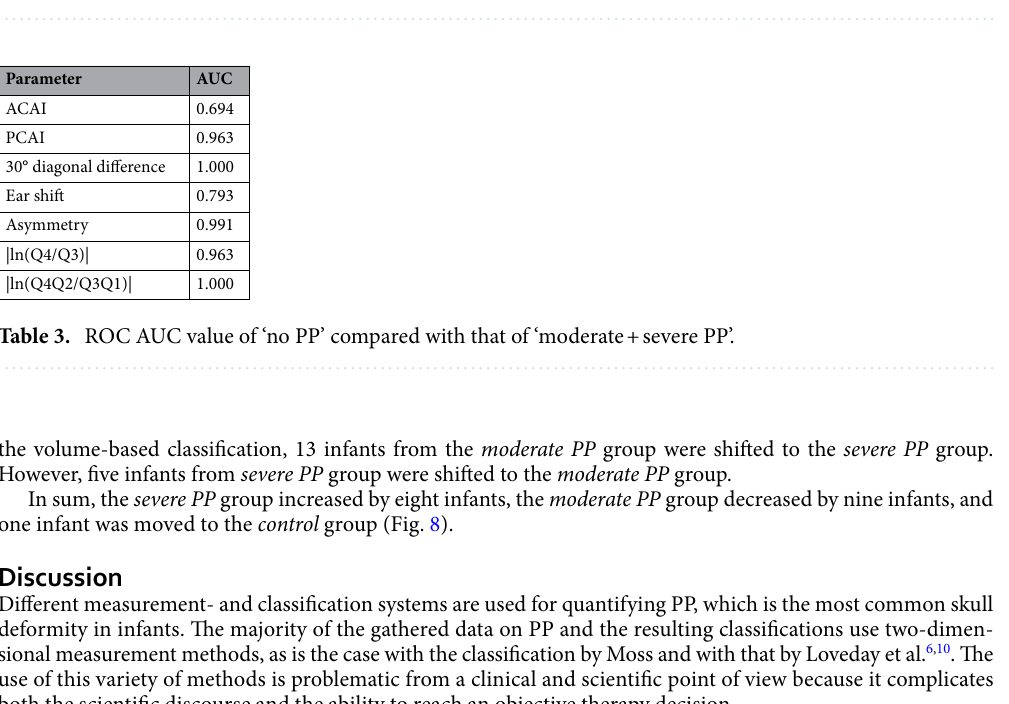
Figure 6. ROC curves of ‘no PP’ compared with those of ‘moderate + severe PP’.